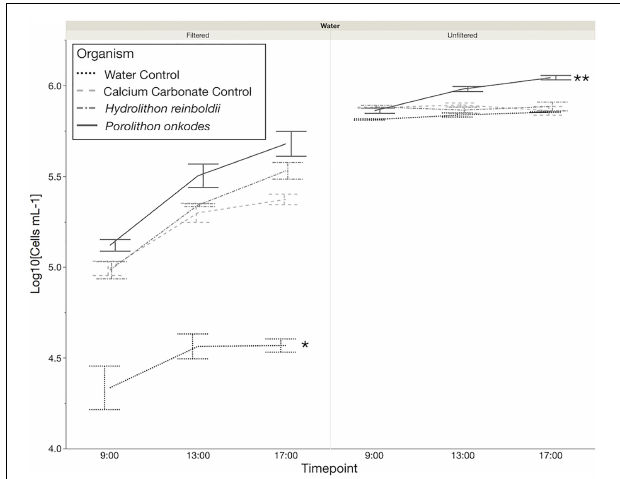
FIGURE 2 | Microbial community growth over 8 h. Flow cytometry was used to quantify the cells mL − 1 , which were log10 transformed. ∗ Water control Tukey P < 0.0029, Tukey p < 0.05. ∗∗ Porolithon onkodes , Tukey p < 0.0199; significant differences based off of change in cells from the beginning of the incubation to the